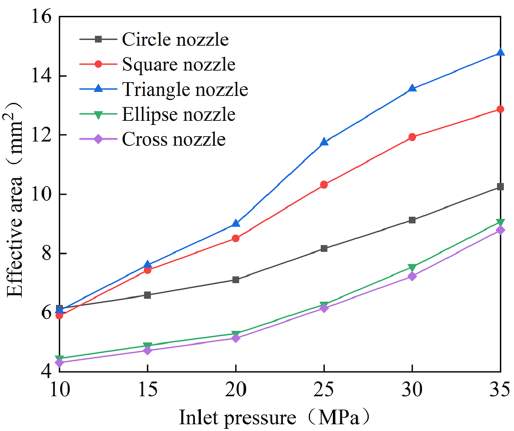
Figure 12. Effective impact area of five nozzles under different inlet pressures when x = 100 mm.